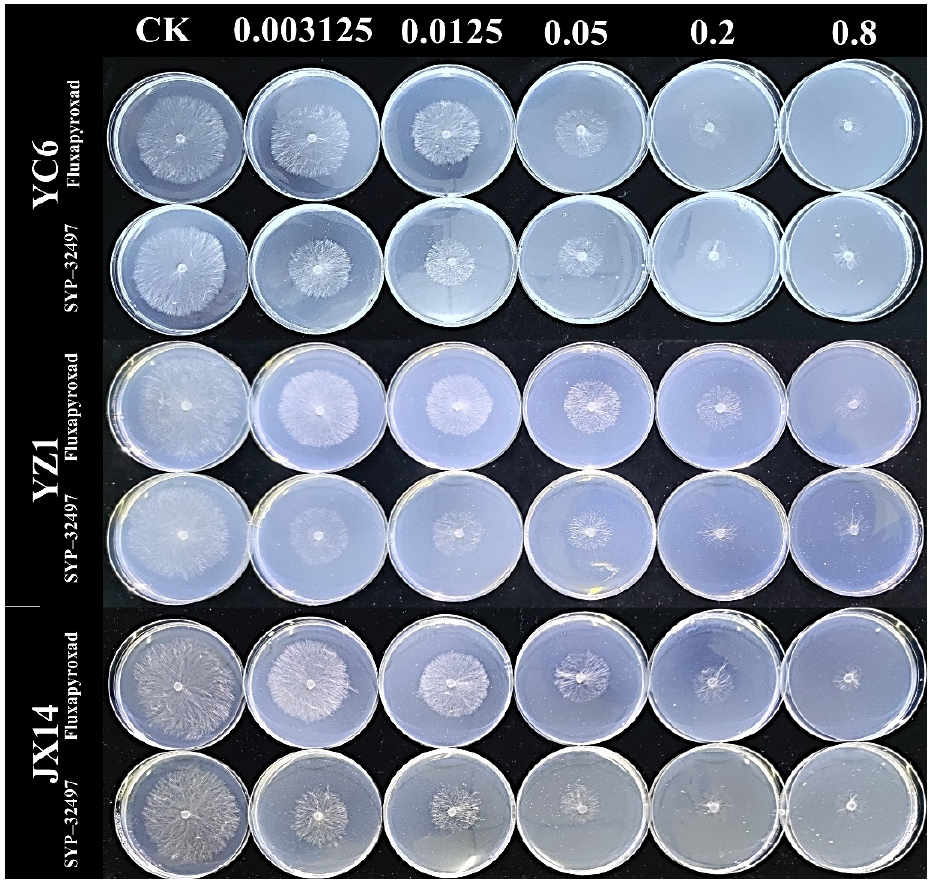
Figure 5. Mycelial inhibition of R. solani (YC6, YZ1, JX14) treated with different concentrations of fluxapyroxad and SYP-32497.